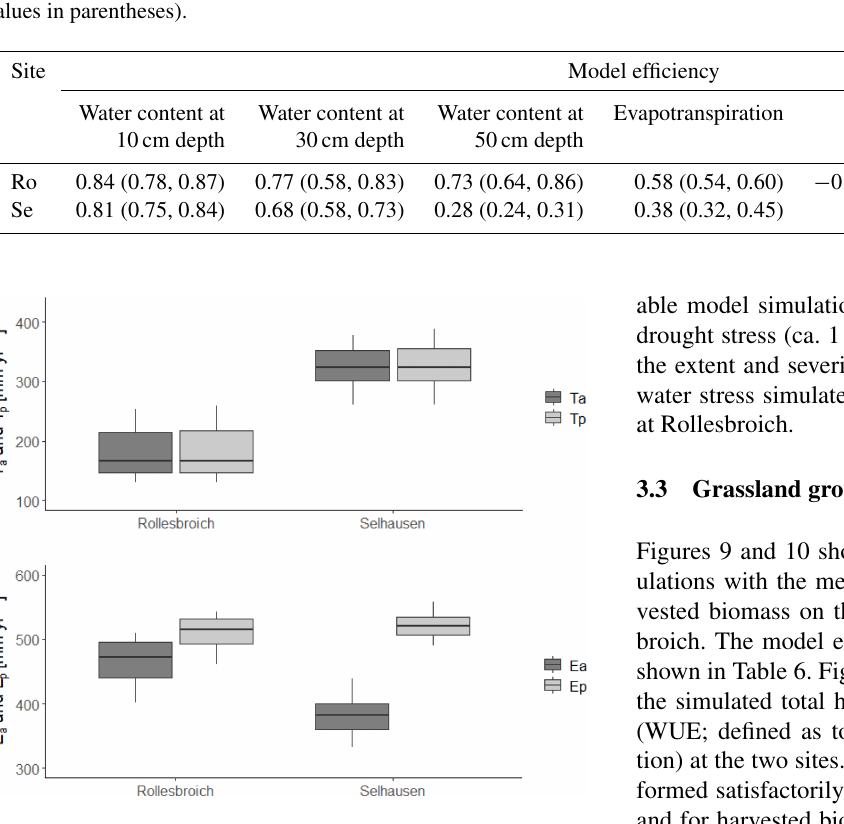
Figure 7. Simulated water balance terms for the 30 acceptable sim- ulations at each site. For an explanation of the box-and-whisker plots, see the caption of Fig.